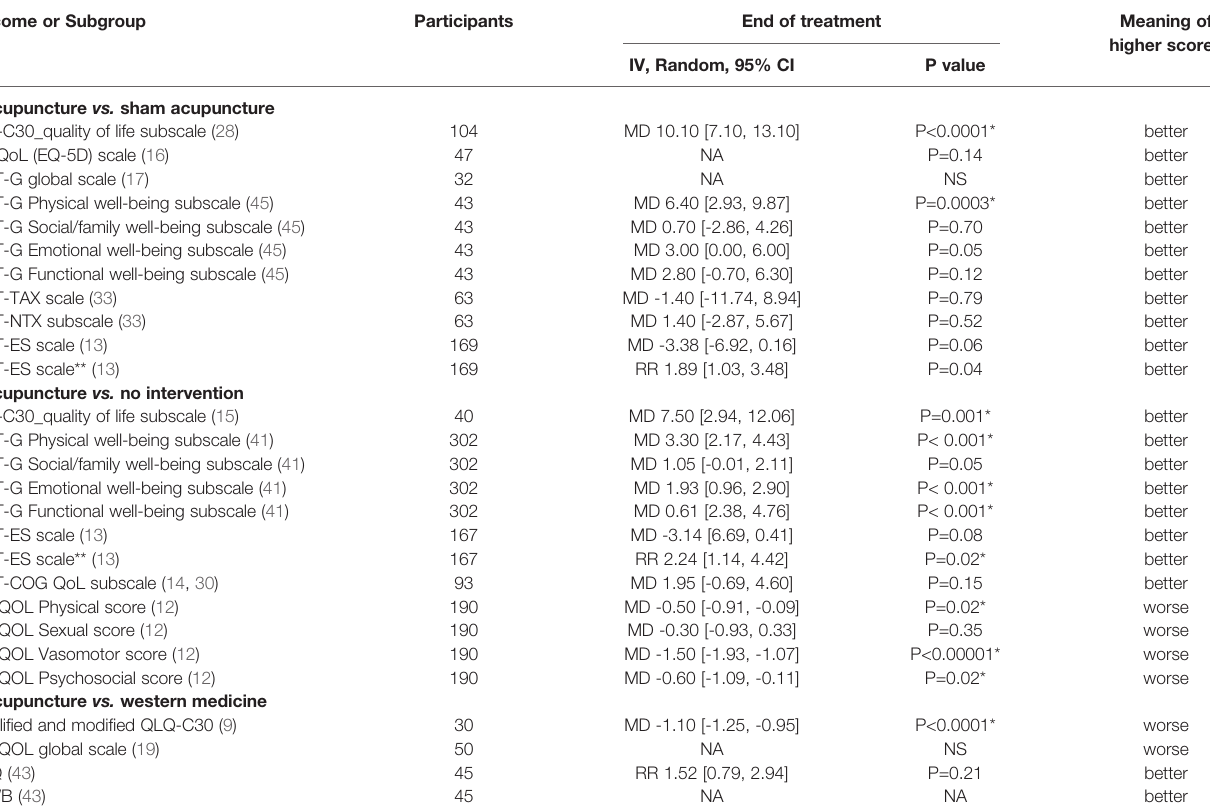
TABLE 2 | The effect of acupuncture on the QoL compared to different comparators. Outcome or